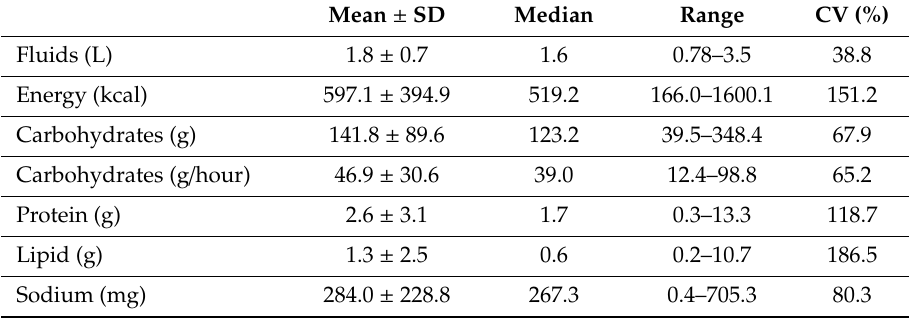
Table 4. Nutritional intake through drinks and food during the marathon ( n = 69). Mean ± SD Median Fluids (L)